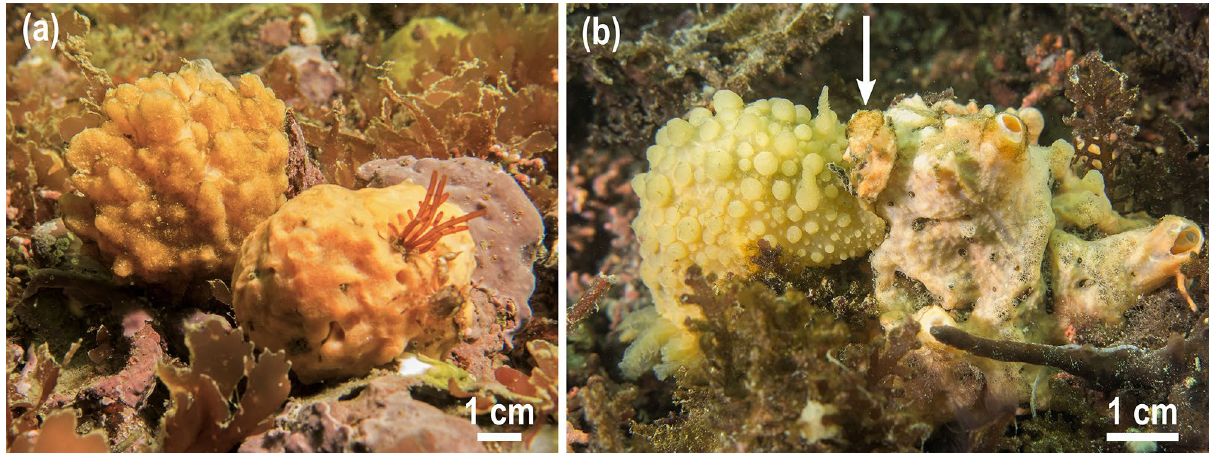
Figure 1. ( a ) View of two individuals of Hymeniacidon perlevis growing on the maerl beds of the Bay of Brest (France). ( b ) An individual of Doris verrucosa (left) feeds on the sponge H. perlevis (right). The arrow indicates the wound made by the nudibranch when feeding on the sponge, showing the inner tissues of the sponge of a darker orange color than the